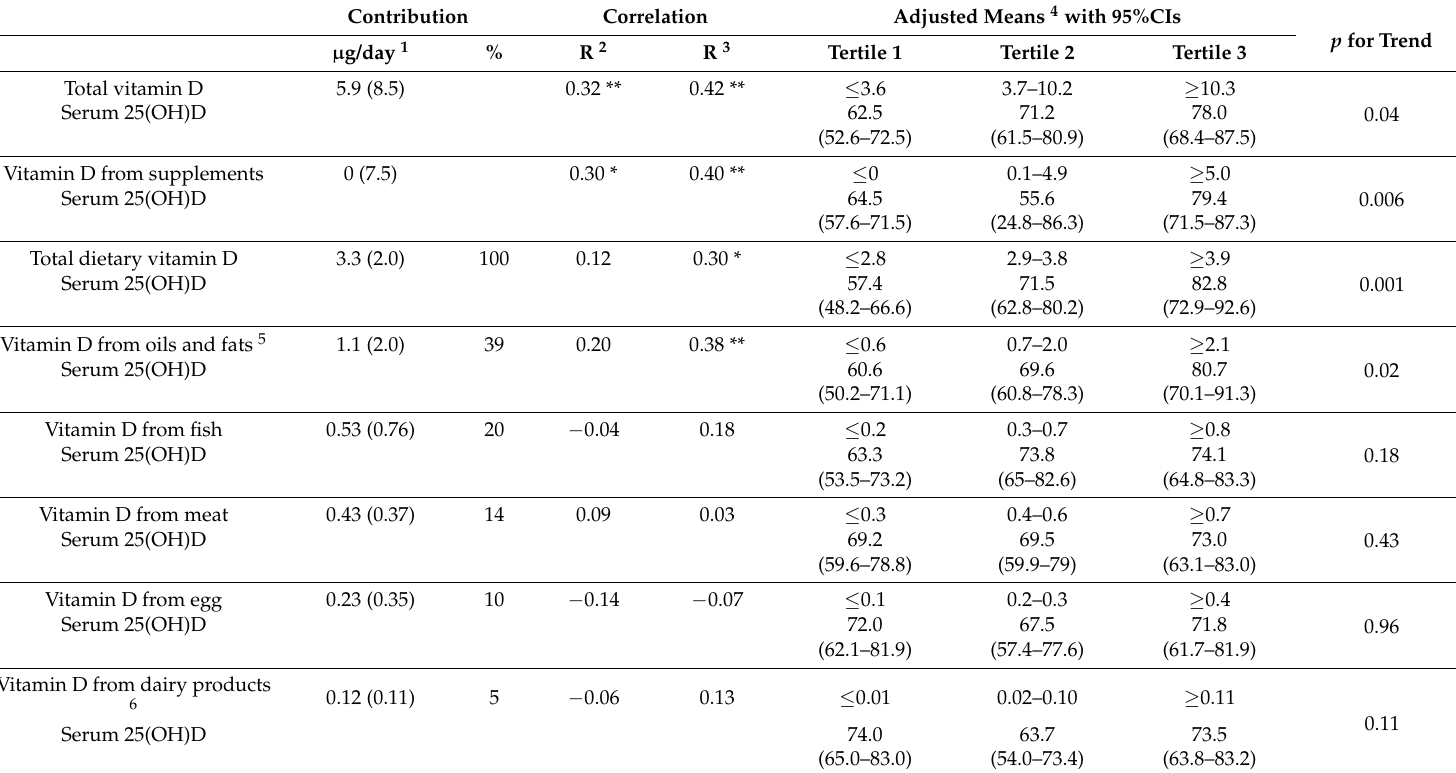
Table 3. Absolute ( µ g/day) and relative (%) contribution of dietary sources to total dietary vitamin D intake, Spearman’s rank and partial correlation coefficients (R) between vitamin D intake and serum 25(OH)D levels, and adjusted means with 95% confidence intervals for serum 25(OH)D levels (nmol/L) according to tertiles of vitamin D intake ( µ g/day) among Dutch women with a pregnancy wish ( n =